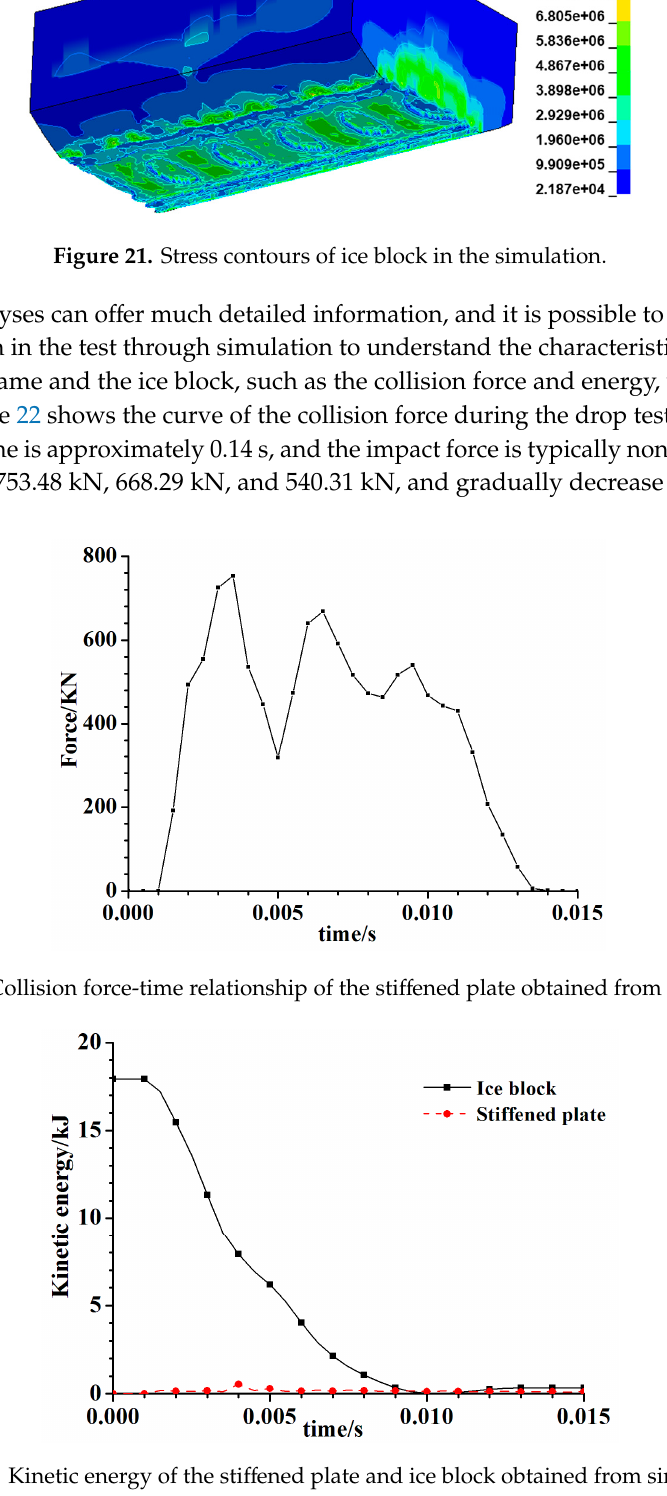
Figure 24. Internal energy of the stiffened plate and ice block obtained from simulation. Figures 23 and 24 show the curves of the kinetic energy and internal energy of the ice block and stiffened plate. It can be seen that the kinetic energy of the ice block decreases rapidly during the collision process, the energy of the plate and the ice block is kept at a very small value, the energy absorbed by the ice block is approximately 0.5 kJ, and the internal energy of the structure is approximately 2.31 kJ, which is mostly due to the slightly larger deformation and the hard fragmentation of the ice block. The stiffened plate frame absorbs most of the energy. The comparison between the simulation and test is summarized and shown in Table 2. It can be noted that in the test, the energy absorbed by the plate frame is smaller than that in the simulation, which is partly due to the calculation method of applying a uniform pressure until the deformation